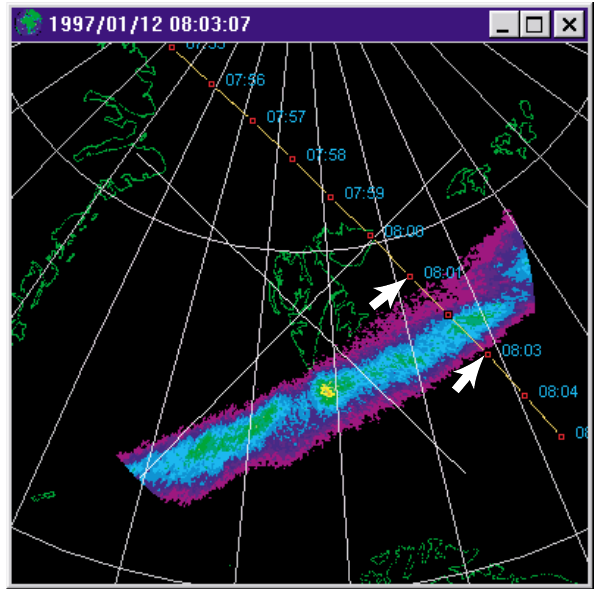
Fig. 5. All-sky image at 630nm from Longyearbyen projected to 250km altitude on a geographical grid, where the magnetic north- south and east-west azimuths of Longyearbyen are shown for ref- erence. The footprint of the FAST spacecraft is overlayed, and the two white arrows indicate the time interval of Fig.